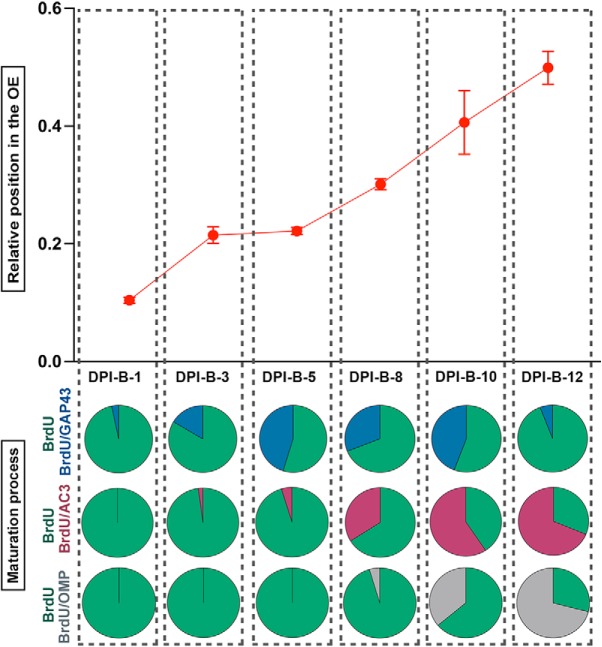
Summary correlating migration and maturation of P25-born OSNs in the ventral zone of the septal OE. Top diagram shows the relative radial position of BrdU+ cells throughout the OE during a 12 d timecourse following BrdU administration. Pie charts located on the bottom half of the diagram show the percentage of the following costaining cells: BrdU+/GAP 43+ (blue), BrdU+/AC3+ (red), and BrdU+/OMP+ (gray) of the total number of BrdU+ cells counted. BrdU+ cells not expressing any other marker are represented in green. Dotted vertical columns represent each time point of analysis after BrdU administration: DPI-B-1, DPI-B-3, DPI-B-5, DPI-B-8, DPI-B-10 and DPI-B-12.